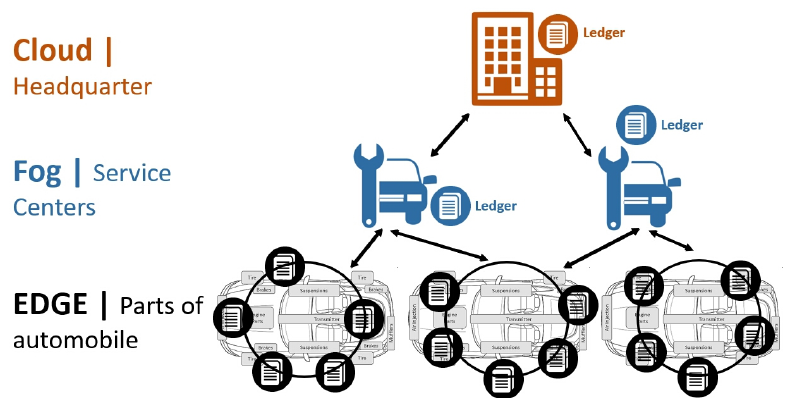
Figure 1. Adapting Fog Computing in Auto Services in Blockchain